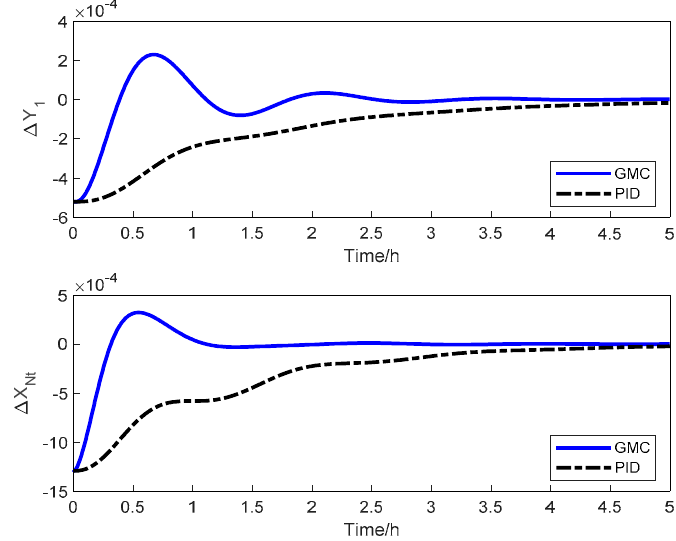
Figure 15. Servo response curve at the top and bottom of the tower. To make a more precise comparison between the two controllers, we retune the parameters of PID and try to make the responses of the top tray basically consistent with each other, as shown in Figure 16. It can be observed from the figure that the control effect of PID at the top of the column is similar to that of GMC, but at the bottom of the column, PID deteriorates significantly, where the response cannot reach a stable state for a long time. Due to the nonlinearity and interaction of the process, if PID achieves the same control effect as GMC at the top of the column, the control effect at the bottom of the column cannot be guaranteed. Therefore, PID cannot consider both ends at the same time, so a compromise must be made between the top and bottom trays when tuning the parameters of PID. If the elimination of the offset at both ends has a priority, the response speed would be sacrificed, as shown in Figure 15. On the contrary, if the response speed has to be considered first, the system would oscillate for a long time, as shown in Figure 16. Considering that stability is more important, PID in Figure 15 is preferred, compared with that in Figure 16. In contrast, GMC can make a good balance between control accuracy and